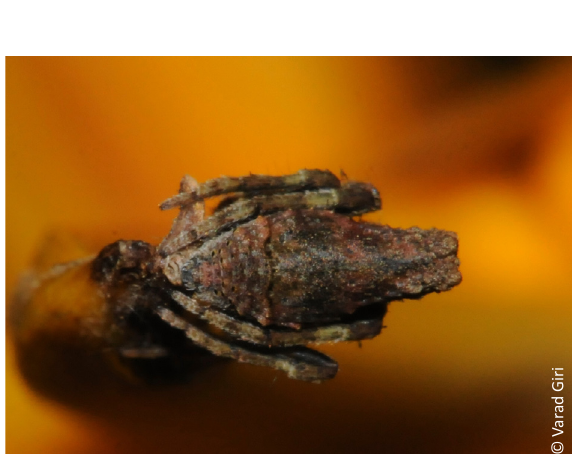
Image 2. Poltys columnaris - female abdomen venter showing maculae